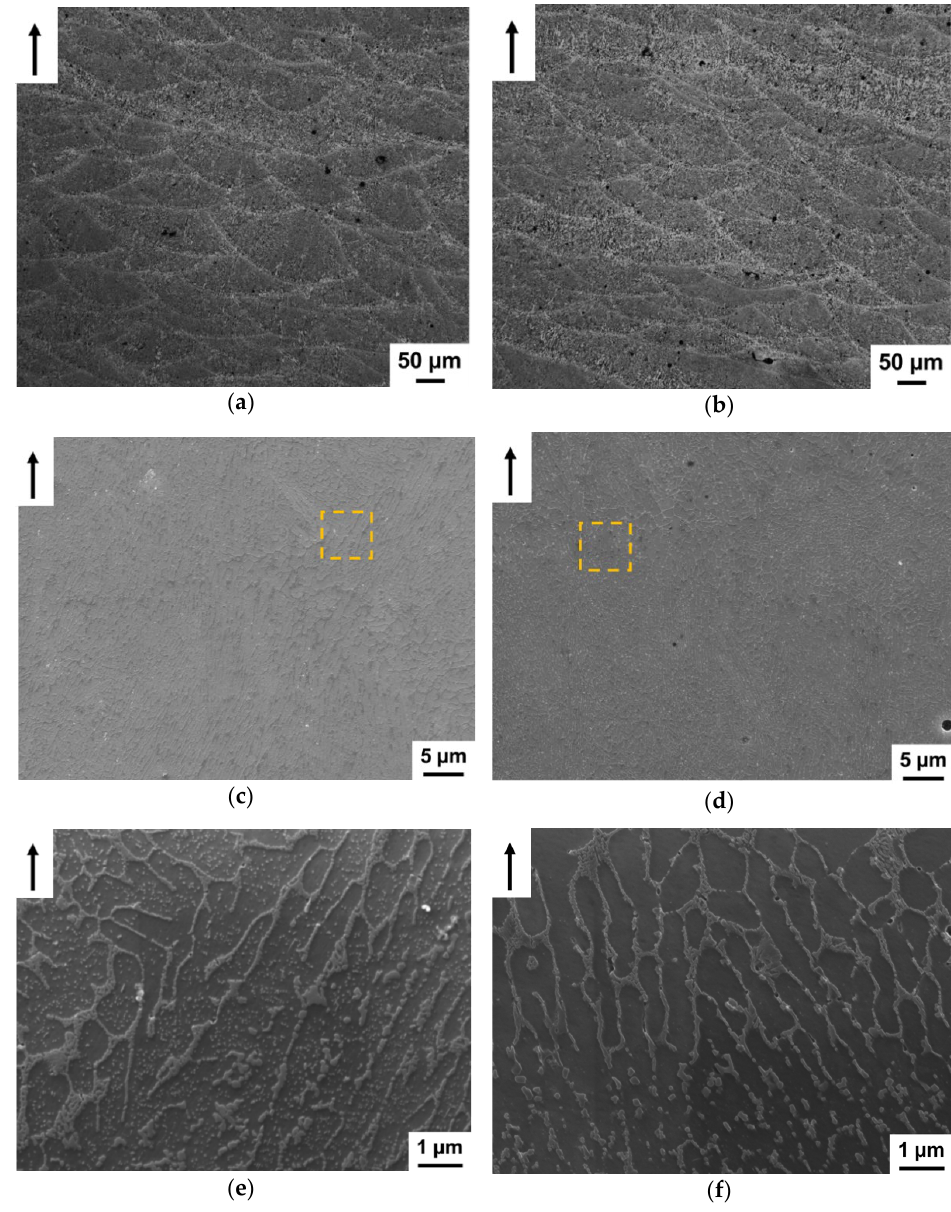
Figure 10. Microstructures obtained at ( a , c , e ) 0 (bottom) and ( b , d , f ) 60 (top) mm from the building platform (XZ cross-section for samples produced in area 1).( a , b : MO, x100; c , d : SEM, x5000, 15 kV, 10.5 mm, 80 pA, SE; e , f : SEM, x30000, 15 kV, 10.5 mm, 80 pA, SE). Highest magnifications ( e , f ) were shot from framed areas of ( c ) and ( d ).